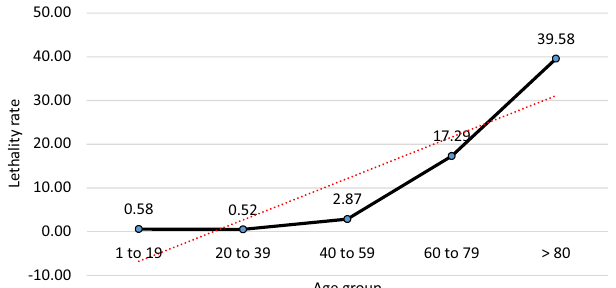
Figure 3. Fatality rate by age group of cases of SARS-CoV-2 infection in the State of Pará-Amazon-Brazil, 2020. Source: OpenDataSUS, Ministry of Health.